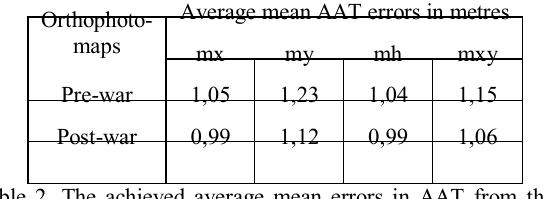
Table 2. The achieved average mean errors in AAT from the individual triangulation